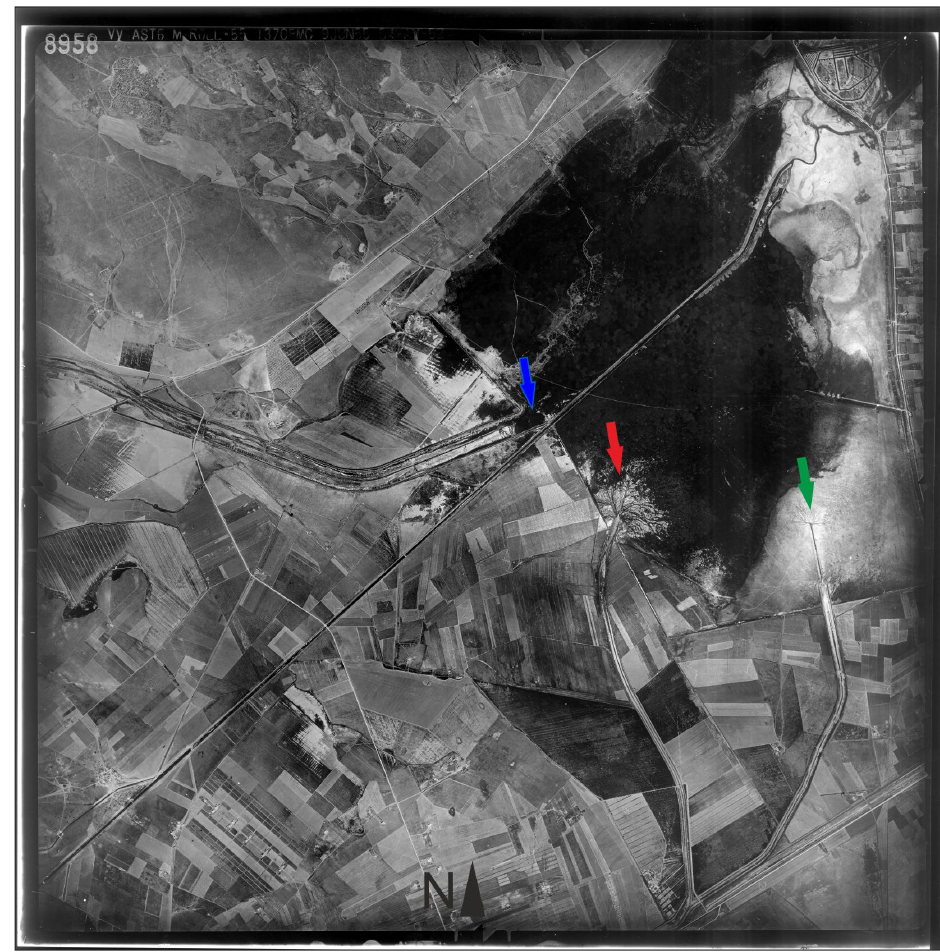
Figure 10. Aerial photo from 1954 (sheet 164, swath 138, photography 8958; aerial photo of Istituto Geografico Militare; licence number 7156 of 15 March 2023; www.igmi.org (accessed on 5 February 2023) showing the filling of polders obtained by the compartmentalisation of the Salso lake by means of embankments. The filling is obtained by the canals Roncone del Cervaro and Salinetri (which diverted the turbid load by the Cervaro stream and are indicated by the red and the green arrows, respectively), and by the canalised section of the Candelaro stream (blue arrow). Note the deltas of sediment that the canals Roncone del Cervaro and Salinetri formed in the polder and how it was already partially filled in the southern and eastern edges. In 1960, the canals Roncone del Cervaro and Salinetris were decommissioned and the Salso lake landfill was terminated. Compare this figure with Figure 9b,c.